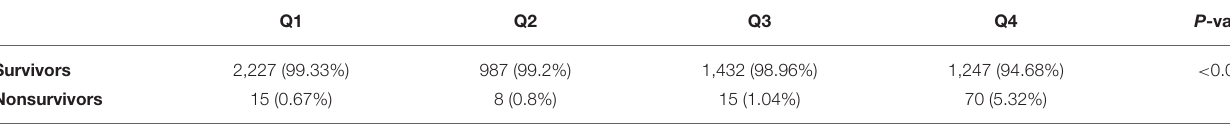
TABLE 3 | The relationship between postoperative serum creatinine with hospital mortality.